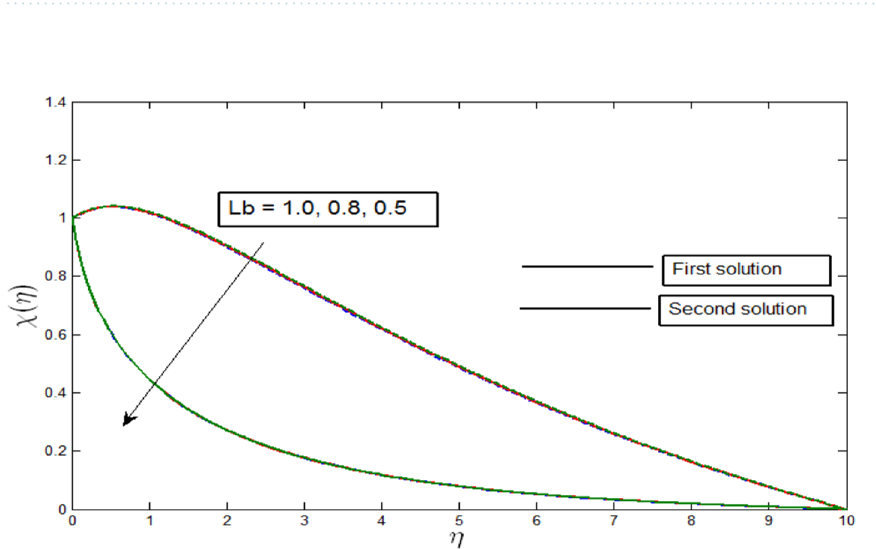
Figure 13. Microorganism profile χ(η) for various Lb when (cid:31) = − 4, γ = 5, Le = 1, Pb = 0.5, Nr = 0.5, Rb = 0.6, A =